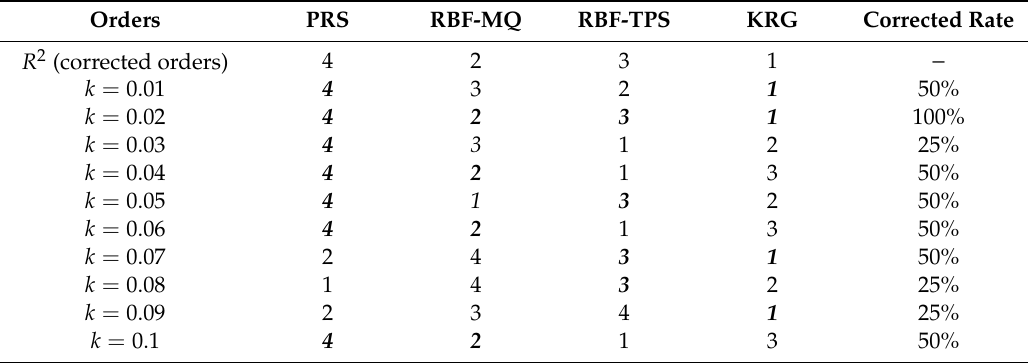
Table 4. Ranking results of surrogate models by MOA-CV with di ff erent σ .